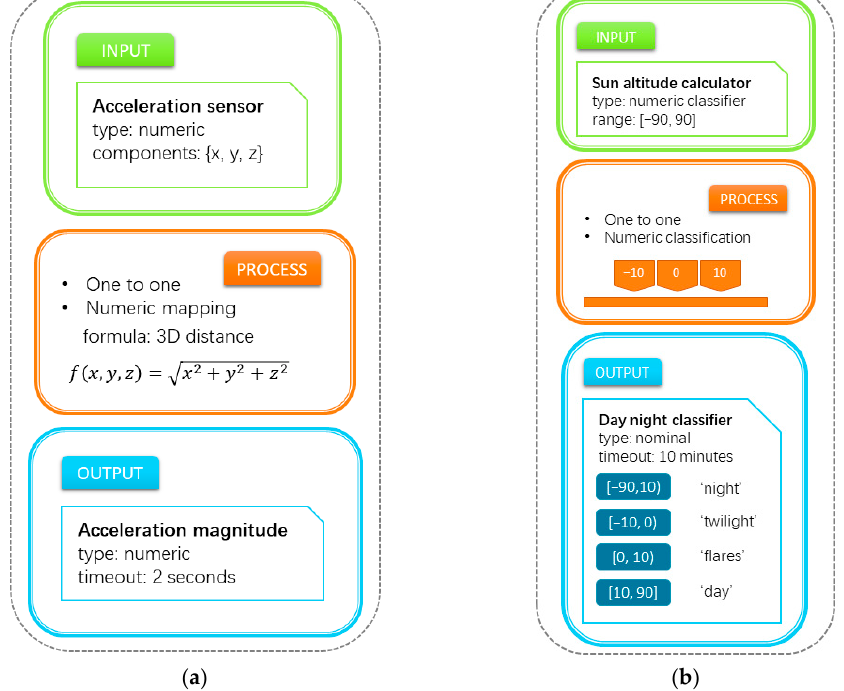
Figure 4. Numeric input-processing types. ( a ) Configurable node with a processing function based on the 3D distance formula with numeric output. ( b ) Configurable node with decisional processing based on a classifier with nominal output.